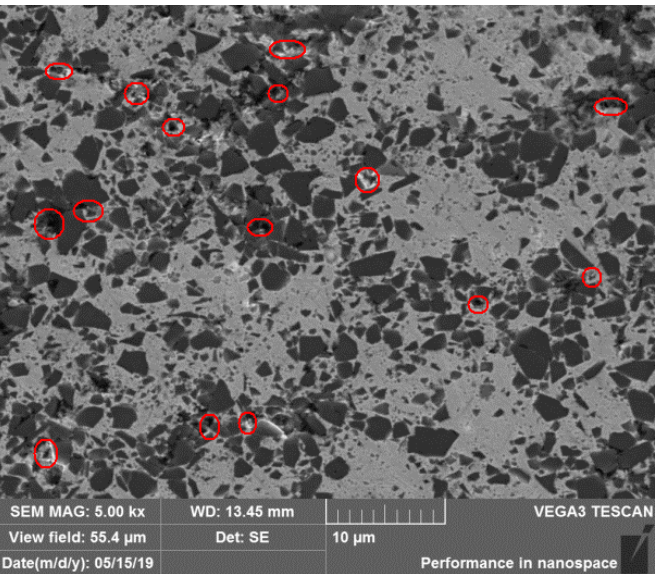
Figure 7. The voids in the sintered microstructure of the Cu-20 wt.% B 4 C composite (some voids are marked in red circles).